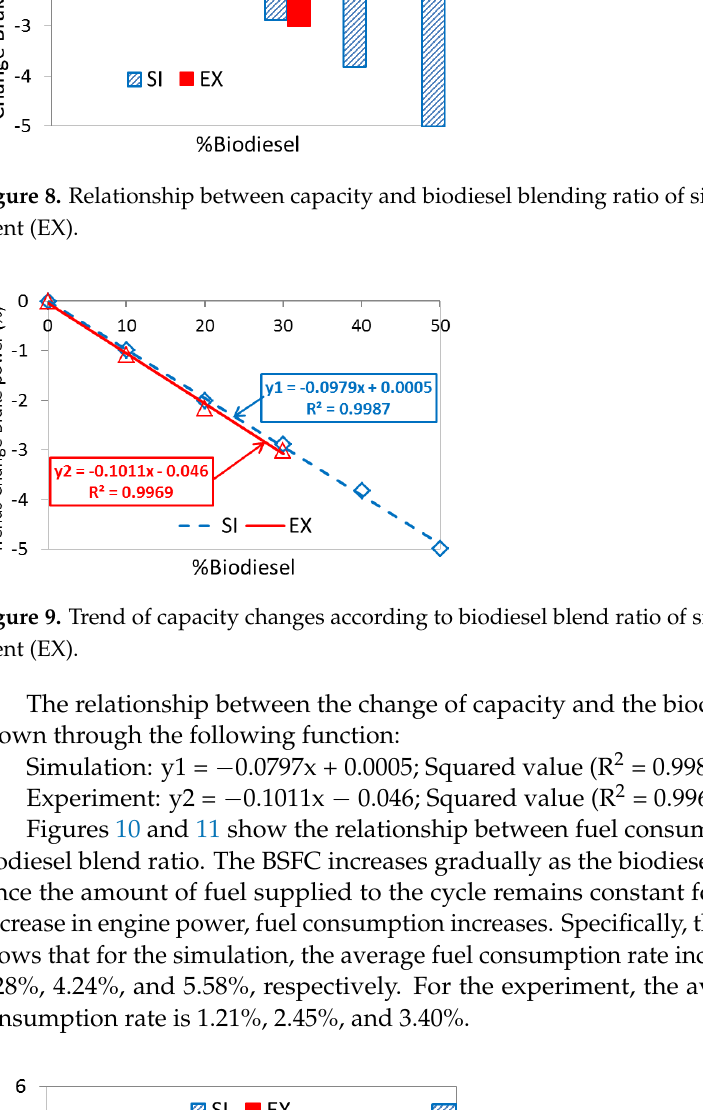
Figure 10. Relationship between BSFC and biodiesel blending ratio of simulation (SI) and experi- ment (EX).